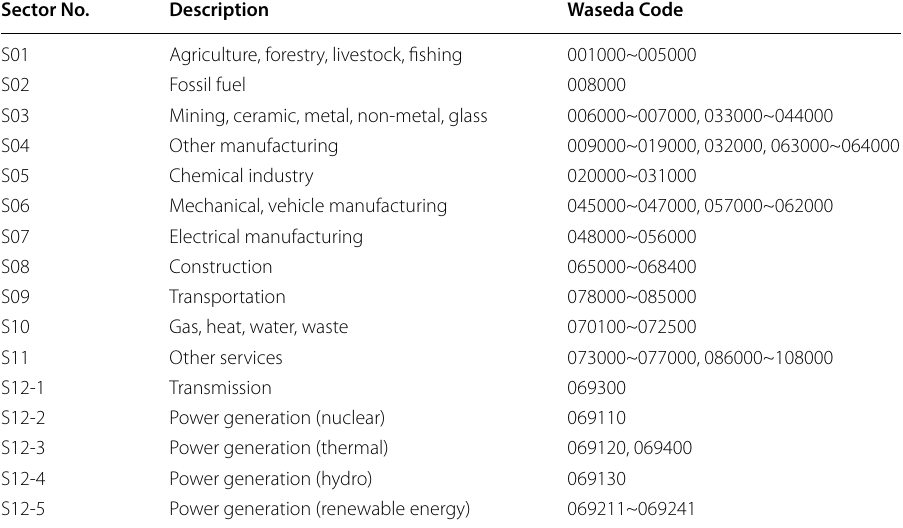
Table 1 Industrial sectors Sector